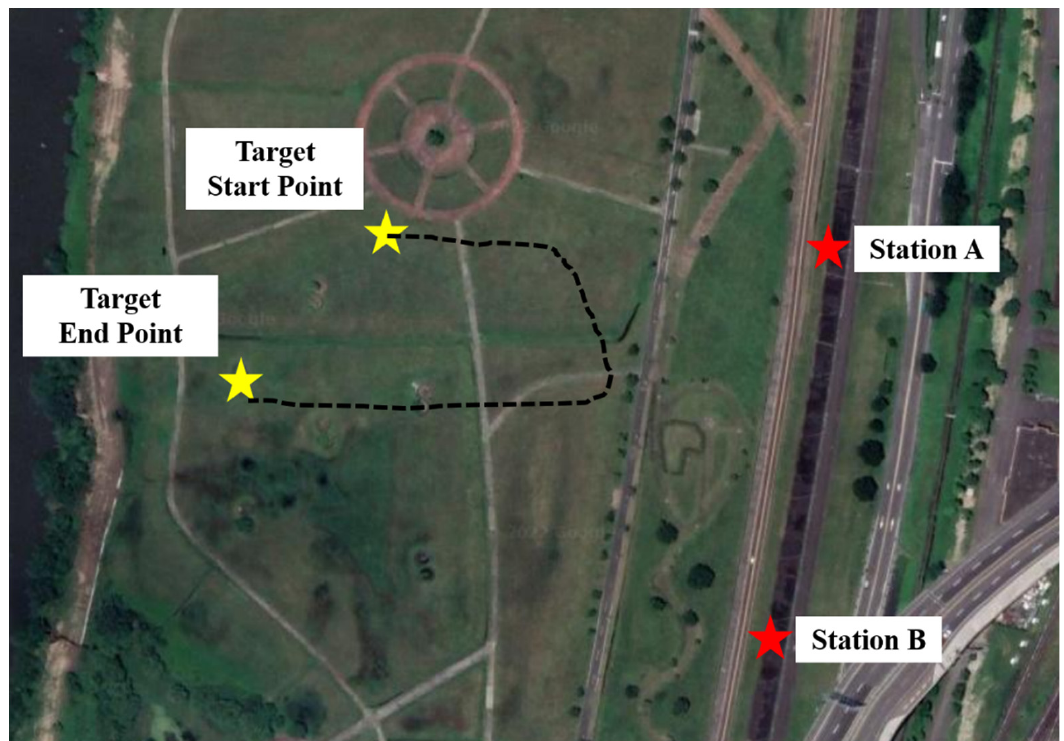
Figure 16. Two-base station system measurement setup.